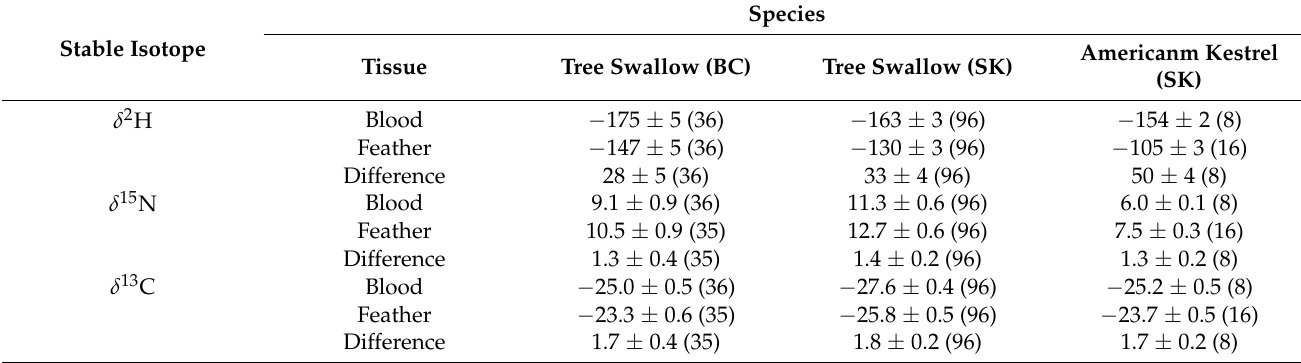
When whole blood lipids were removed (see Methods), pooled swallow blood δ 2 H values were ca. 8‰ more positive at British Columbia (mean ± SD = − 167 ± 8‰) and Saskatchewan ( − 156 ± 2‰), and similar in kestrels ( − 154 ±